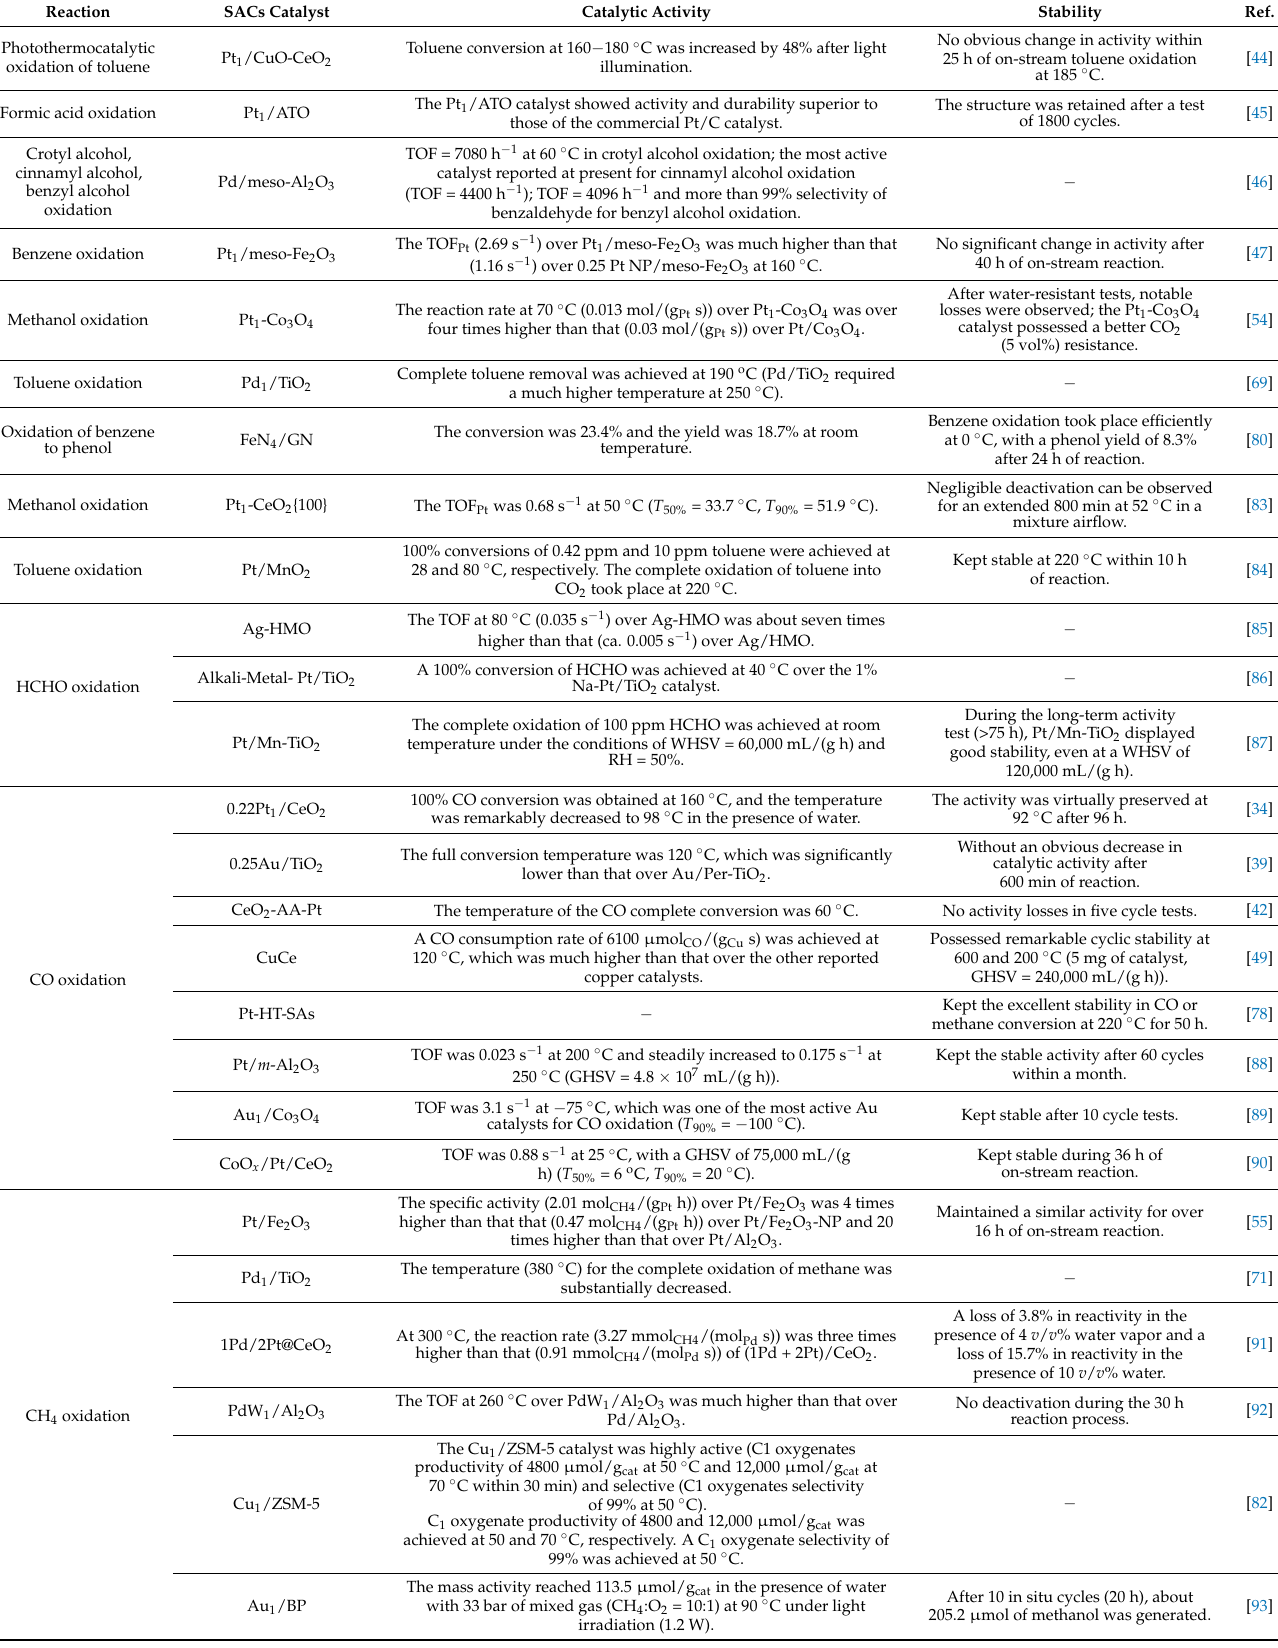
Table 2. Summary of the SACs for applications in environmental